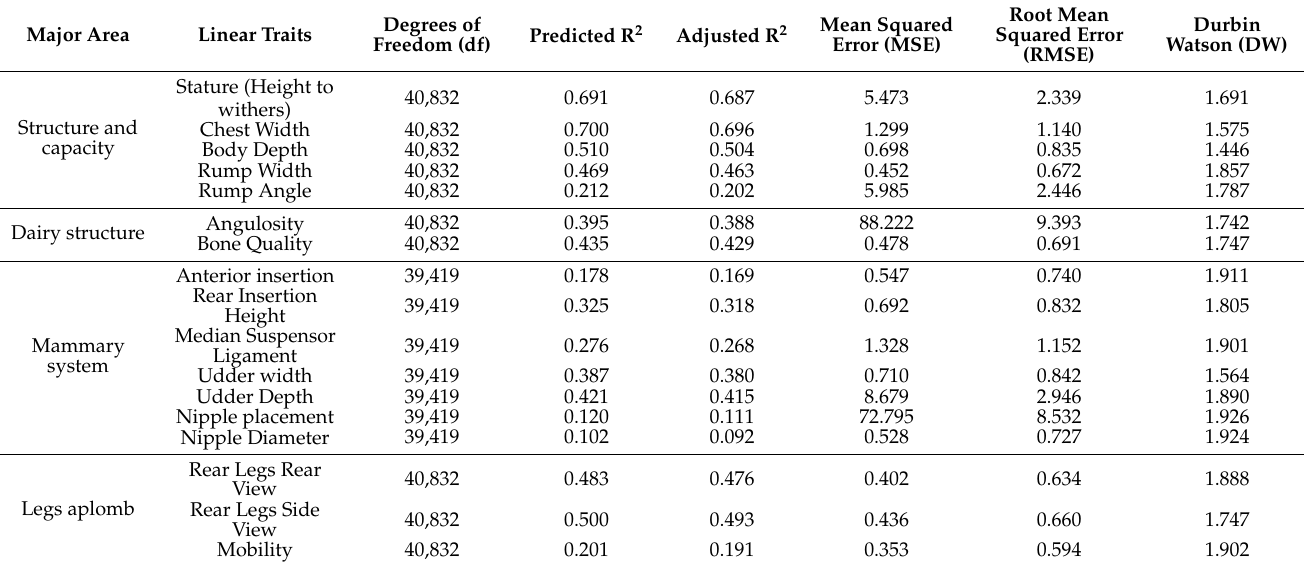
Table 3. Goodness of fit coefficients of the model testing for zoometric traits to LAS scores in Murciano-Granadina primipara and multipara does (41,323) and bucks